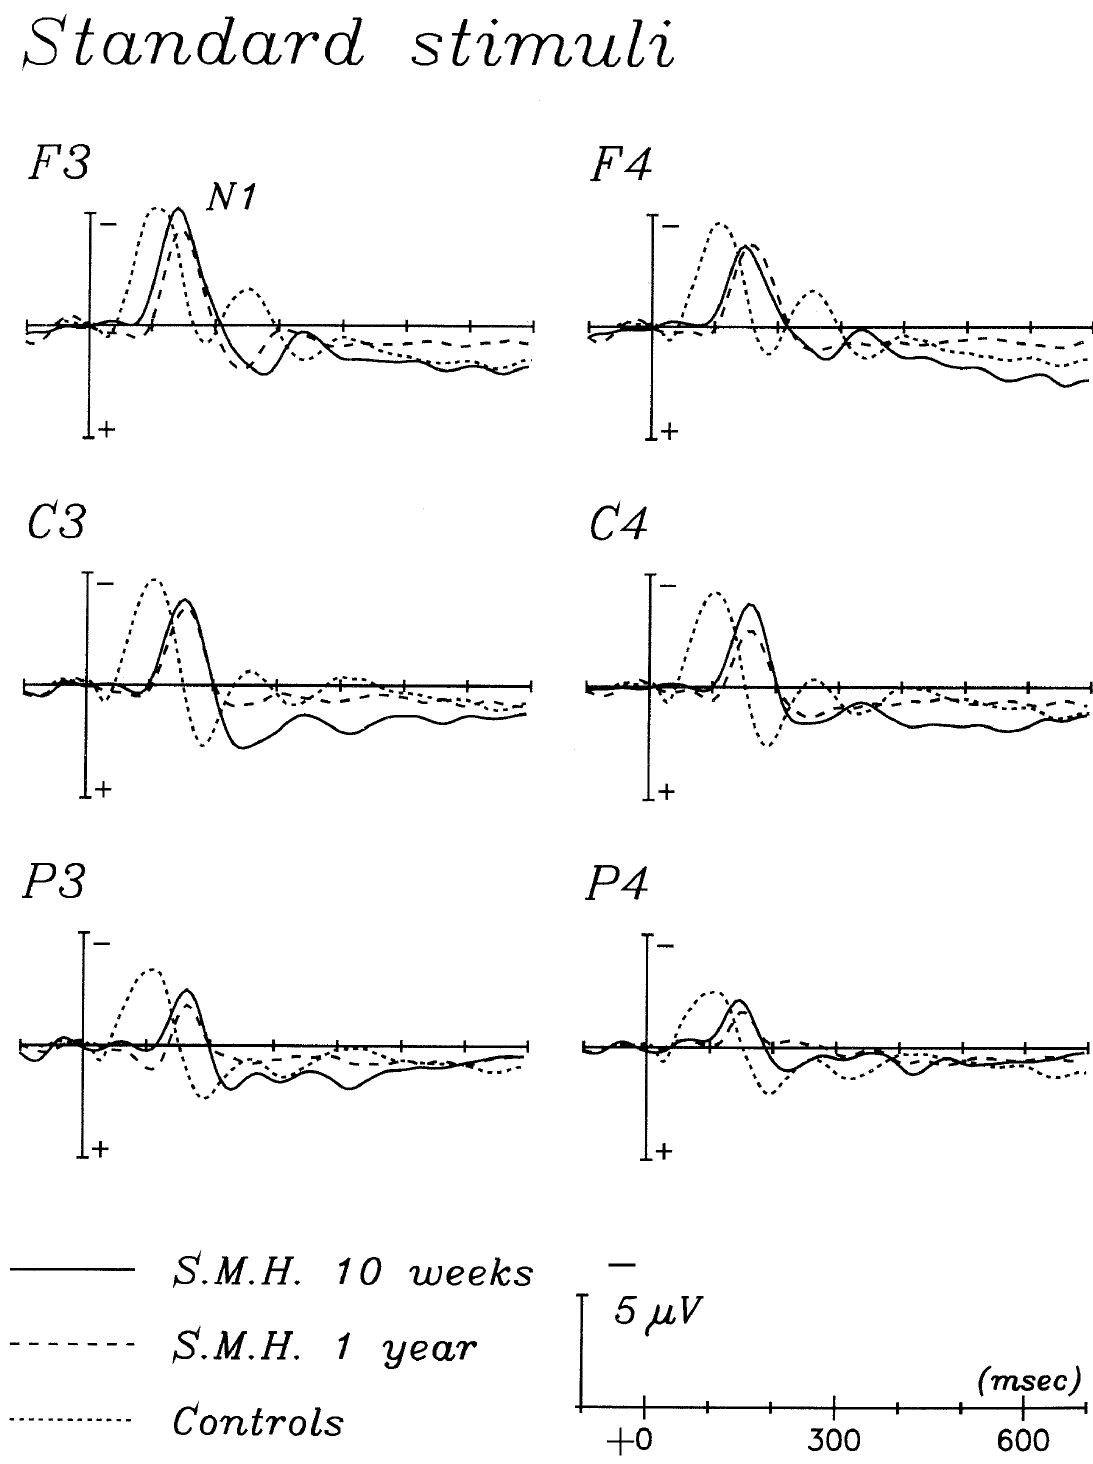
Fig. 3. Auditory event-related N1-potentials to standards at frontal and central scalp sites: Two patient recordings and grand-average waveform to control subjects ( 5) are shown. Left hemisphere: odd electrode numbers, right hemisphere: even (cid:14)(cid:16)(cid:15)